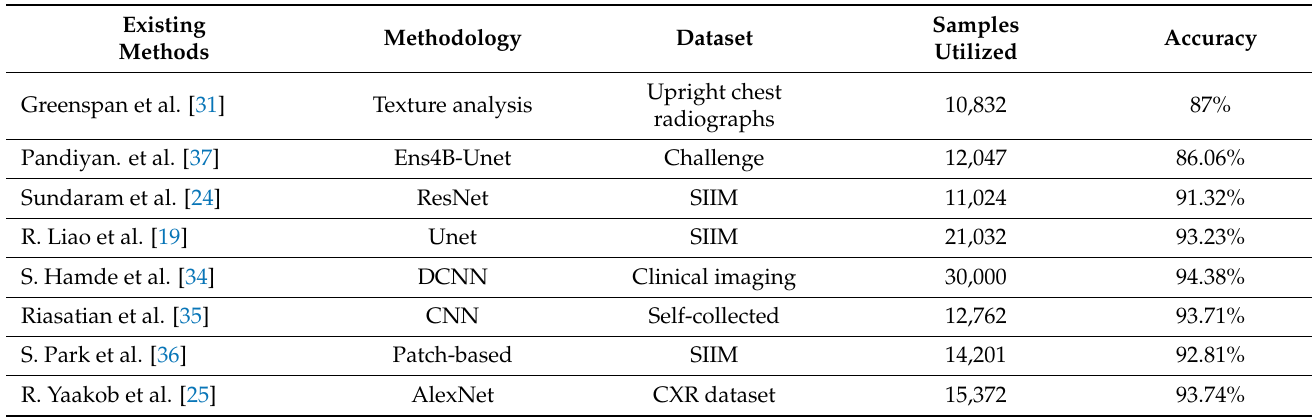
Table 1. Overview of related work.